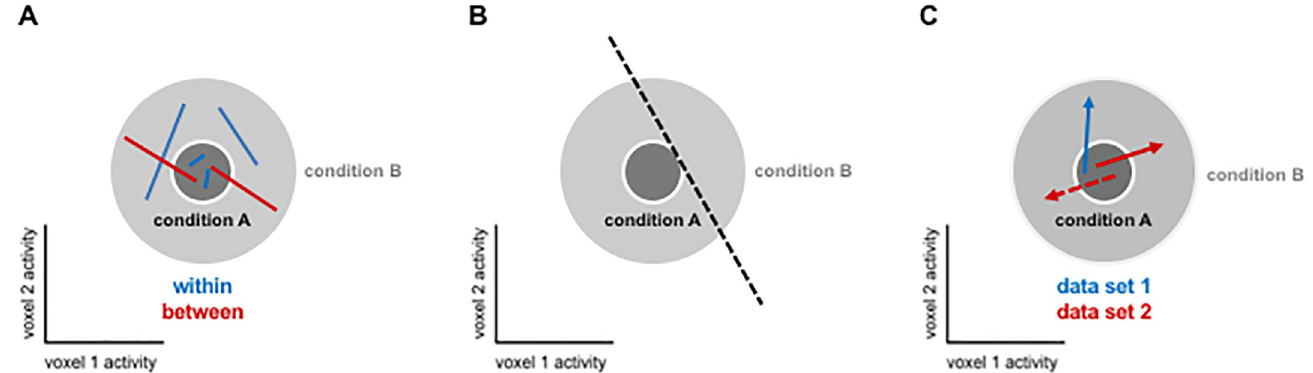
Fig 9. EDI and linear decoding accuracy are sensitive to differences in variance between conditions, but crossvalidated distance estimators are not. Consider two distributions of pattern estimates for two conditions (A, dark gray; B, light gray), which have identical means (central point), but different variances (small for A, large for B). (A) EDI: The mean distance between conditions (red) is larger than the mean distance within conditions (blue), because the distances within condition A are very small. The EDI, therefore, is sensitive to the difference between the conditions. (B) Linear decoder: A linear decoder may maximise its accuracy by placing the decision boundary to one side of the condition-A distribution. This way the decoder gets 100% accuracy for condition A. For condition B, accuracy is below chance (50%), but above 0. On average across conditions, the accuracy will be above chance (50%). Linear decoders, therefore, are sensitive to differences in variance (like the EDI). (C) Crossvalidated distance estimator: A crossvalidated distance estimator (e.g. crossnobis/LDC or LD-t) is a mean of inner products of pattern-difference vectors (arrows: condition-B pattern estimate minus condition-A pattern estimate). On each fold of crossvalidation, an inner product is computed between a training-set vector (blue) and a test-set vector (red). When the distributions are point-symmetric about the mean (e.g. Gaussian), each test-set vector (solid-line red arrow) has an equally probable opposite twin (dashed-line red arrow). The inner products of the training-set vector with the twin test-set vectors (red) will have opposite sign and the same absolute value. These pairs of values will cancel in the expectation. Crossvalidated distance estimates are therefore insensitive to variance differences (as long as the distributions of the pattern estimates are point-symmetric, e.g. non-isotropic Gaussian, for both